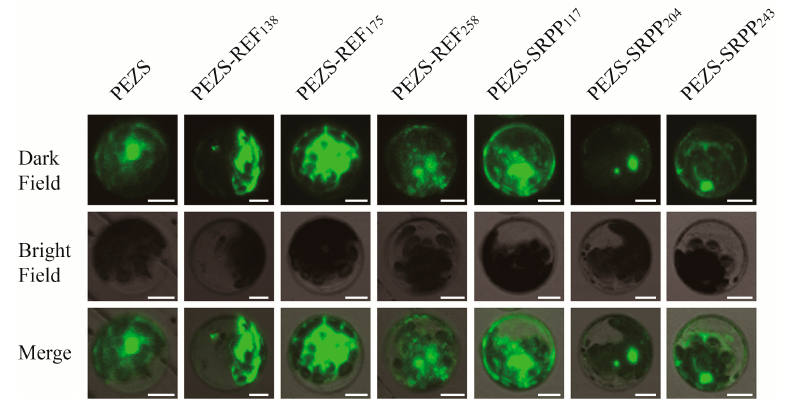
Figure 3. Subcellular localization of REF and SRPP proteins in Arabidopsis protoplasts using GFP-fluorescence. PEZS plasmids containing REF-GFP or SRPP-GFP fusions were transfected into the protoplasts. As a control a PEZS vector (containing GFP alone) was transfected. REF proteins appear to be gathered in the shadow zone of the cell under the view of Bright Field, and SRPP proteins appear to have diffused GFP fluorescence throughout the cells. GFP was excited with an argon laser at 488 nm and fluorescence images were taken using a confocal laser scanning microscope. Scale bars = 10 μ m.